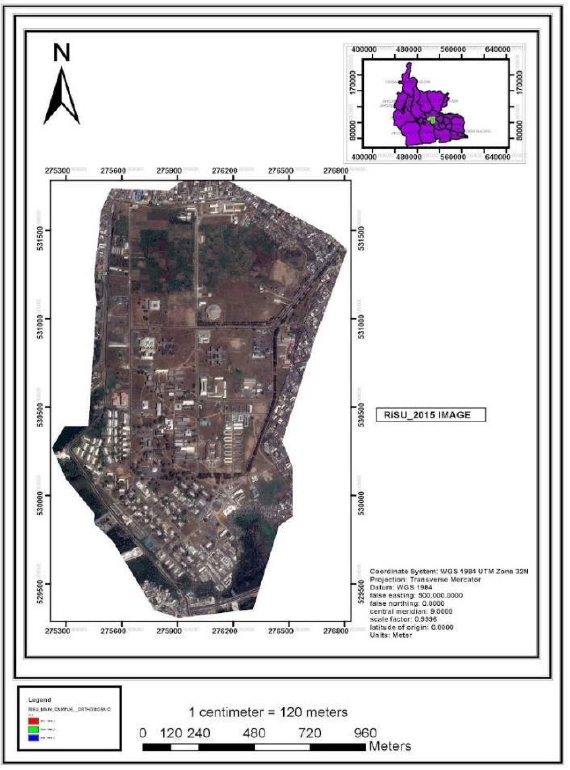
Figure 2: 2015 Sentinel Imagery of Rivers State University Portharcourt campus.